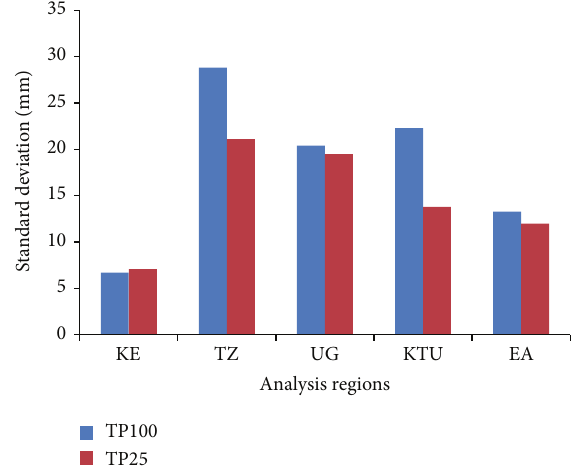
Figure 12: Standard deviation of the mean OND rainfall (mm) for the period 2000–2008, averaged over KTU, remote regions (KE, TZ, andUG,definedinFigure 11),andEA(28 ∘ E–42 ∘ E,12 ∘ S–5 ∘ N).TP100 is due to the simulation with actual topography and TP25 represents simulation when the topography is reduced to 25%.